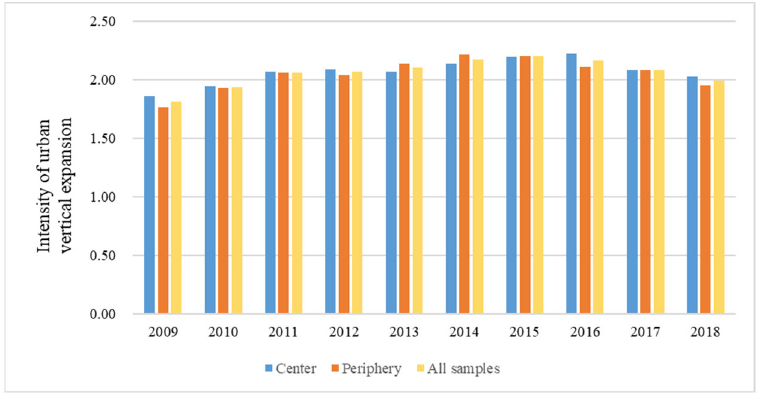
Figure 3. Urban vertical expansion intensity in Jiangsu Province. (Classified by center ‐